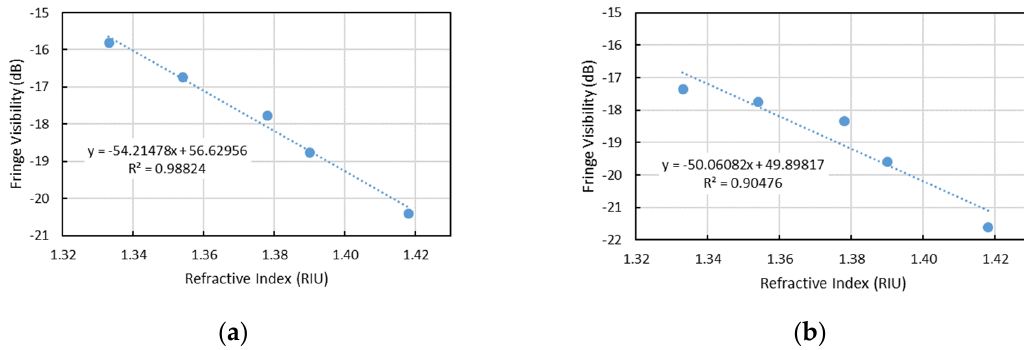
Figure 11. Calibration curve for the FP-long sensor ( L 1 = 80 µm and L 2 = 22.7 cm) using the signal modulation visibility for wavelength ranges ( a ) 1536 nm to 1539 nm and ( b ) 1552 nm to 1555 nm.